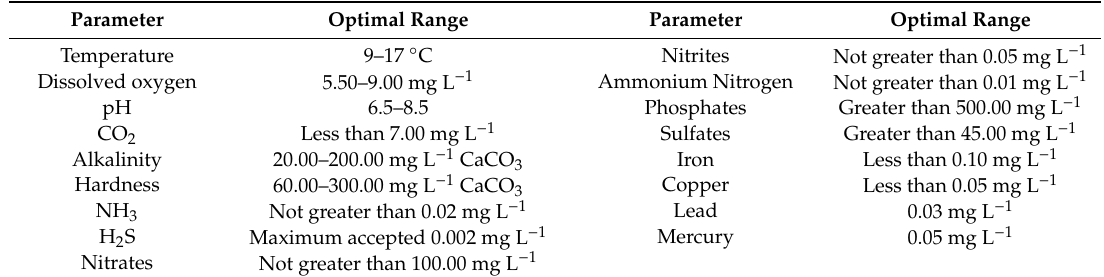
Table 2. Physical and chemical properties of water for rainbow trout farming [45].